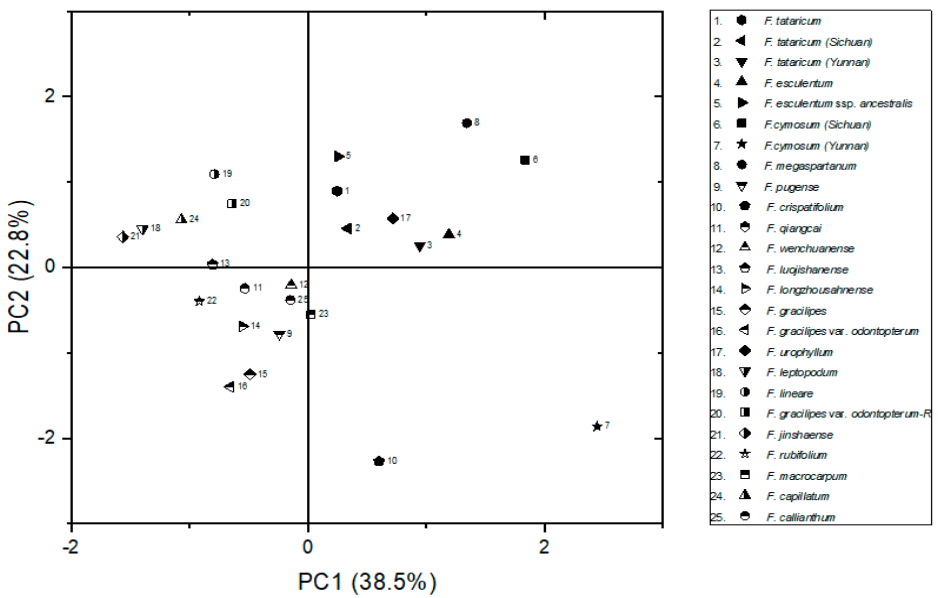
Figure 2. Scatter plot of Fagopyrum based on two main factors of PCA.